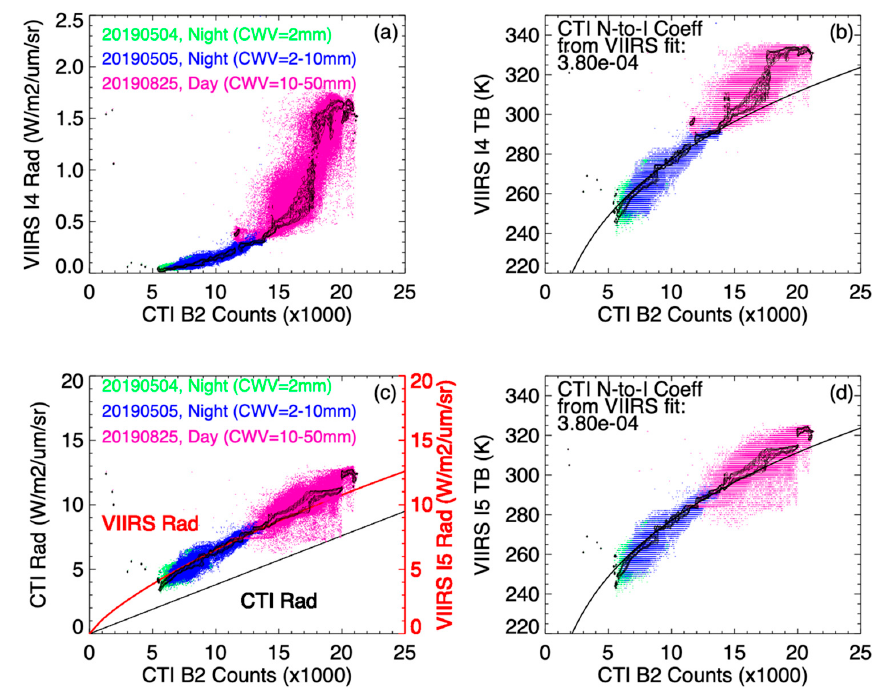
radiance (red curve) in ( a ) was obtained by applying the VIIRS–CTI radiance ratio from Figure A7b. obtained by applying the VIIRS–CTI radiance ratio from Figure A7b.